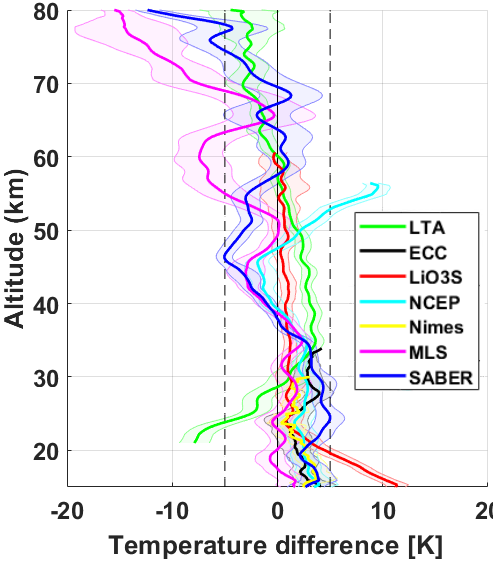
Figure 15. Average absolute difference profile between the tem- perature measured by the various LAVANDE instruments and tem- perature measured by NASA STROZ. The shaded range gives ± 2 standard deviations of the mean and indicates statistical uncertainty at the 95% confidence level. Results for MLS and SABER are for the weighted average profiles, but very similar results are obtained using the closest match SABER or MLS